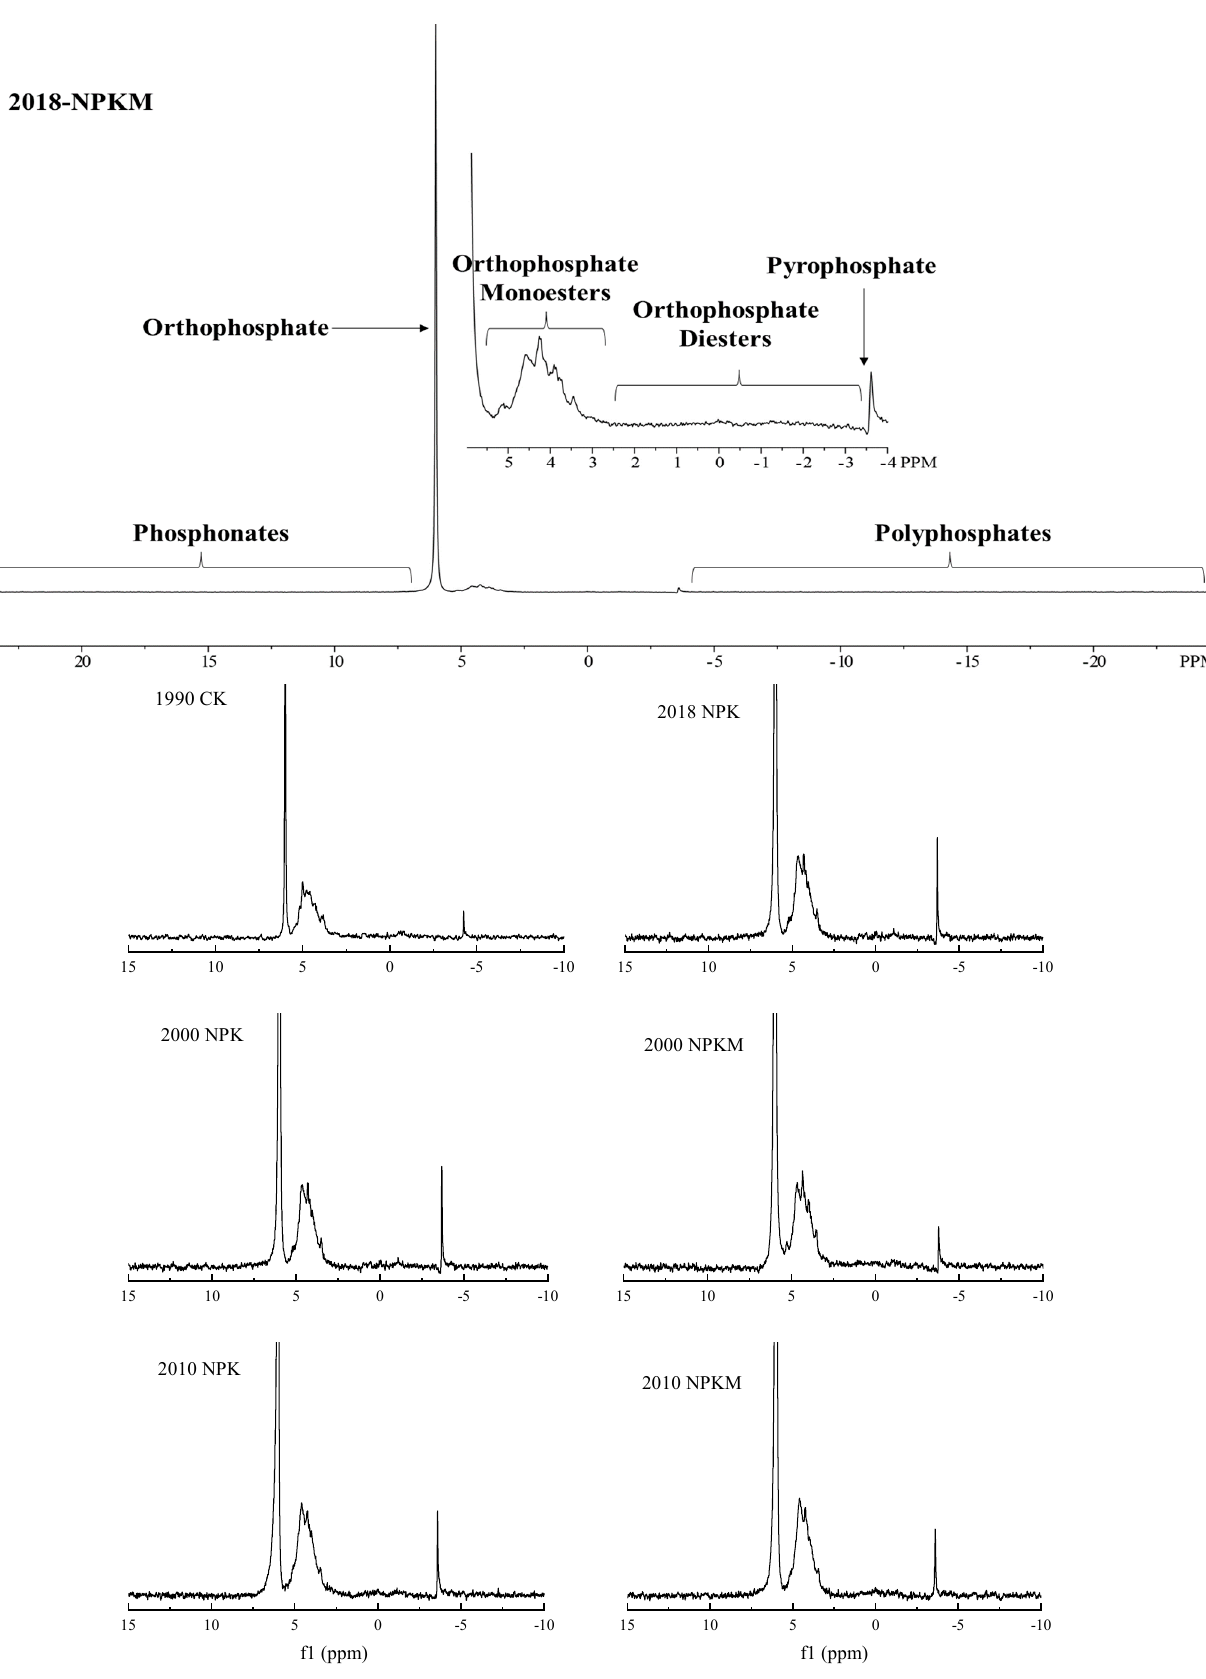
Figure 4. Solution 31 P NMR spectra in the studied soil under long-term field trial in Mollisol. The inserted spectra were used to show more information about the region from 6 ppm to − 4 ppm. CK, no fertilizer input; NPK treatment, applying N, P, K fertilizer; NPKM treatment, applying NPK and manure (pig manure from 1990 to 2004, and cattle manure from 2005 to 2018). Table 3. The proportion of P fraction with NaOH-EDTA extractions of the studied soil under long- term field trial in Mollisol. Year Treatment